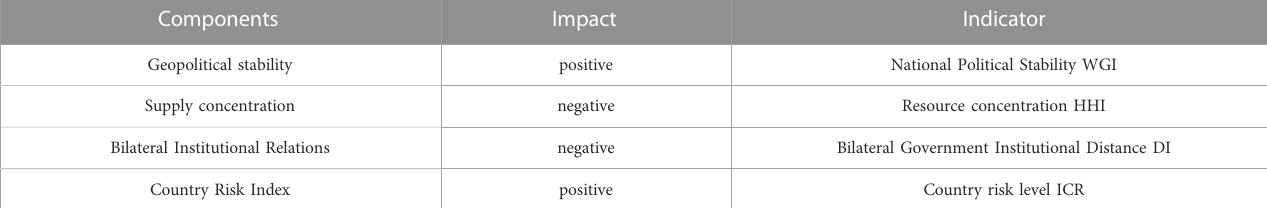
TABLE 1 Indicator system for evaluating the impact of geopolitics on the supply risk of critical metal minerals. Components